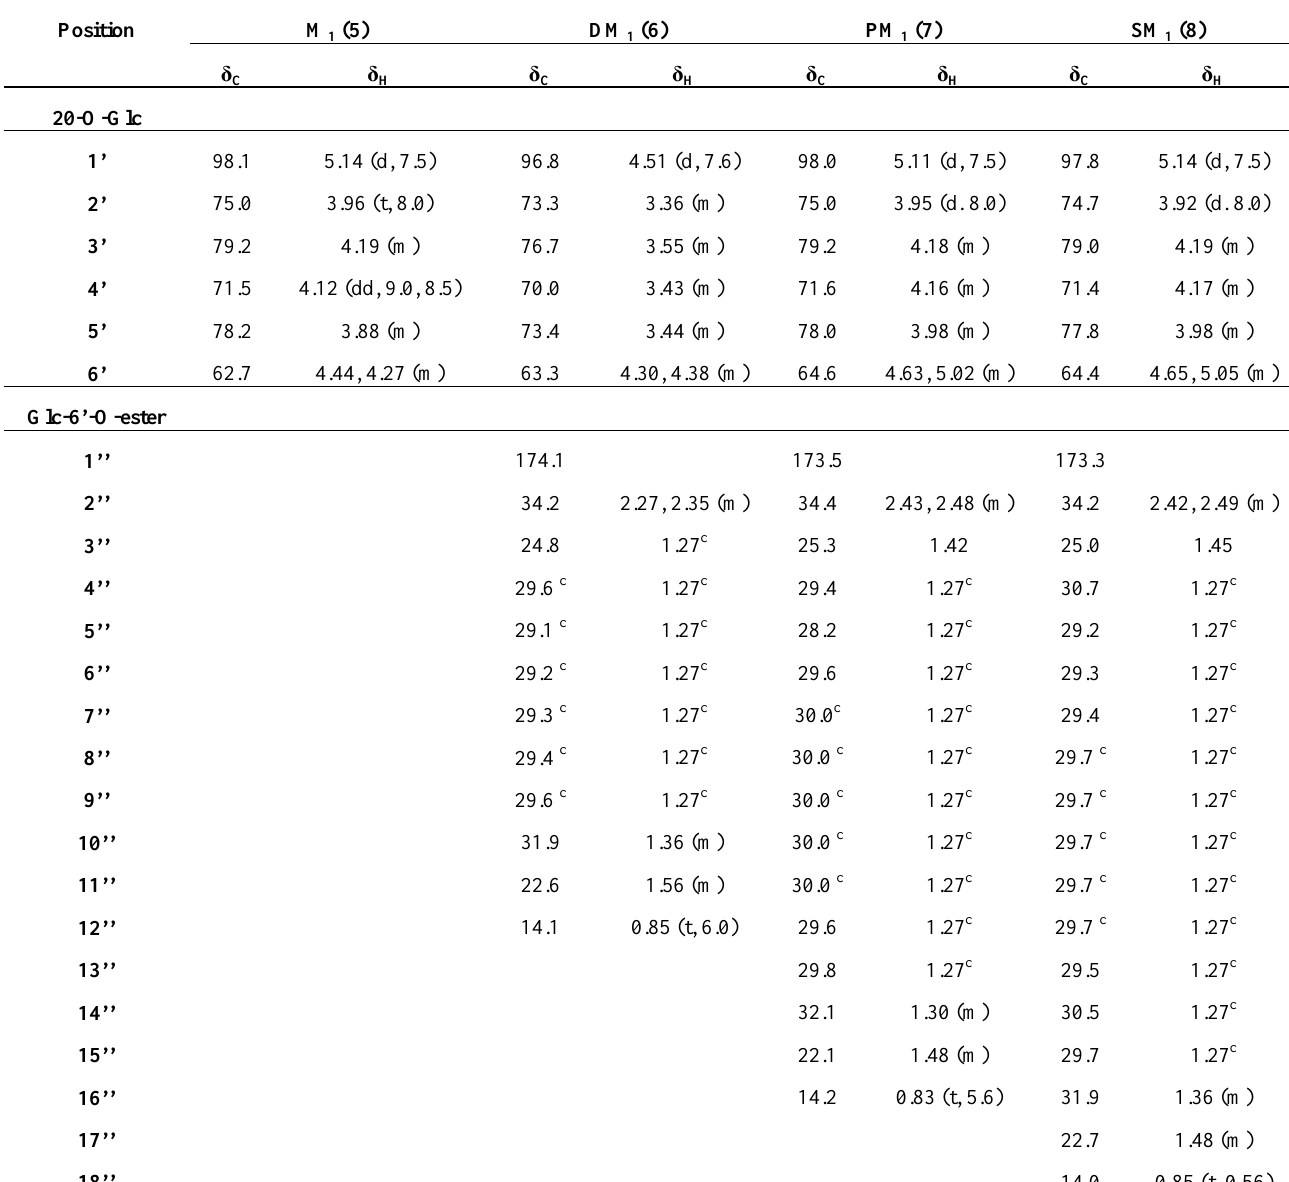
Table 2 . 13 C and 1 H NMR data of sugar and fatty acid ester moieties of compounds 5 - 8 a, b .